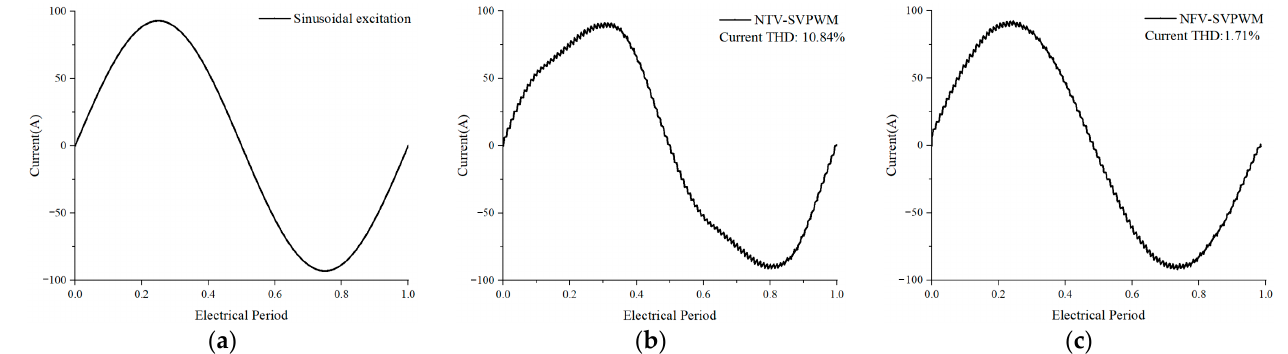
Figure 20. Current excitation under different modulation algorithm: ( a ) ideal sinusoidal, ( b ) NTV- SVPWM, and ( c ) NFV-SVPWM.